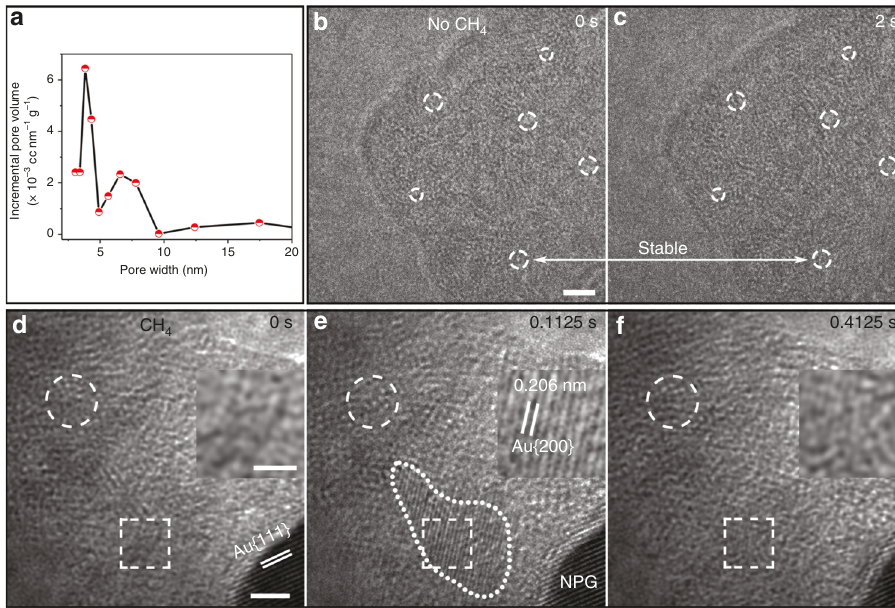
Fig. 3 Characterization of the amorphous carbon layers and in situ dynamic catalysis process of Au SAs. a Size distribution of nanopores in the amorphous carbon layers produced by the ex situ CH 4 pyrolysis reaction (see more details in “ Methods ” and Supplementary Fig. 10). b , c HRTEM images of an amorphous carbon layer at two different moments after the layer was produced and the CH 4 fl ow was stopped with the other conditions of the in situ CH 4 pyrolysis reaction unchanged. The two images have the same scale bar. d – f HRTEM images of an amorphous carbon layer at three different moments during the reaction with all the conditions unchanged. The moments in b and d are de fi ned as 0 s. The white dashed circles in b and c denote the positions of six randomly selected carbon zones at 0 and 2 s, which are typical unchanged regions, and the ones in d – f indicate the positions of a randomly selected carbon zone at 0, 0.1125, and 0.4125 s, which is a typical changed region. The boxes in d – f indicate the positions of a nanoparticle that temporarily formed and disappeared. The insets in d – f are the close-up views of the boxed regions in d – f , respectively. The dashed closed curve in e indicates the boundary of a temporarily formed crystal nanoparticle. b , c and d – f are cut from Supplementary Movies 3 and 4, respectively (see more details in Methods). Scale bars: b 2 nm; d 2 nm; the inset of d 1